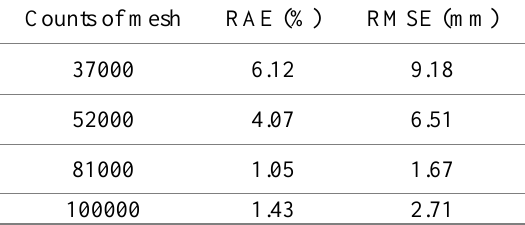
Table 3. errors in simulated water surface profile with different mesh count